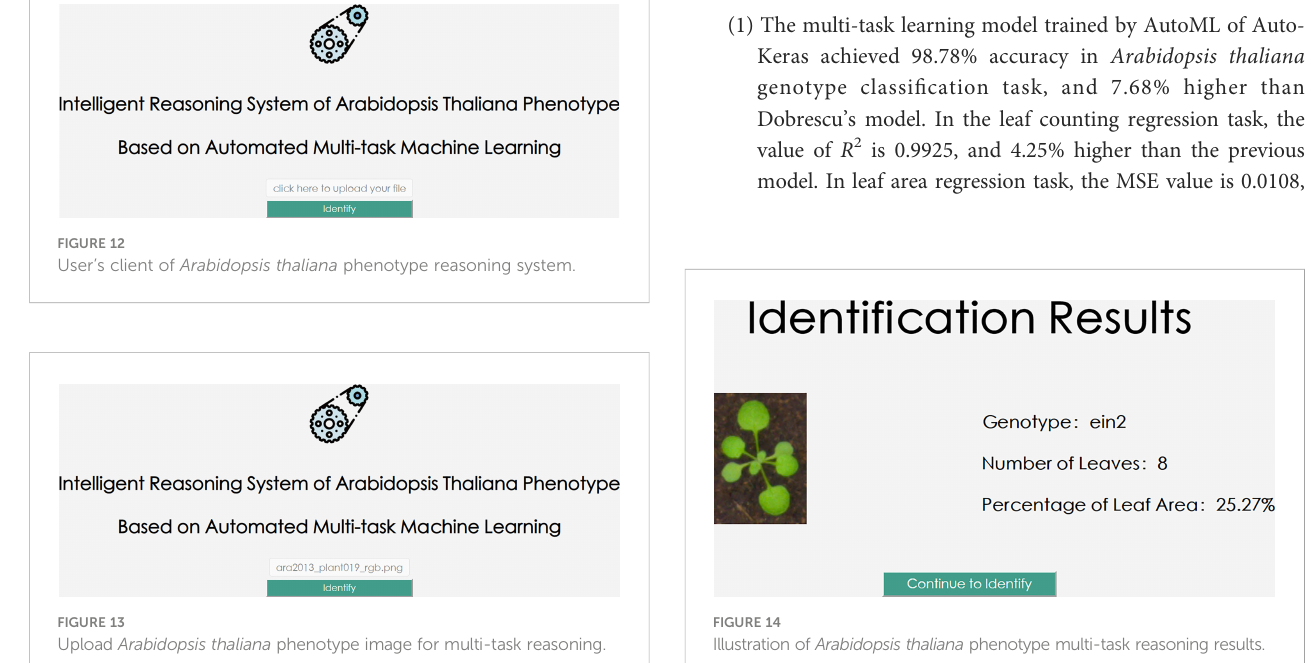
FIGURE 13 Upload Arabidopsis thaliana phenotype image for multi-task reasoning.